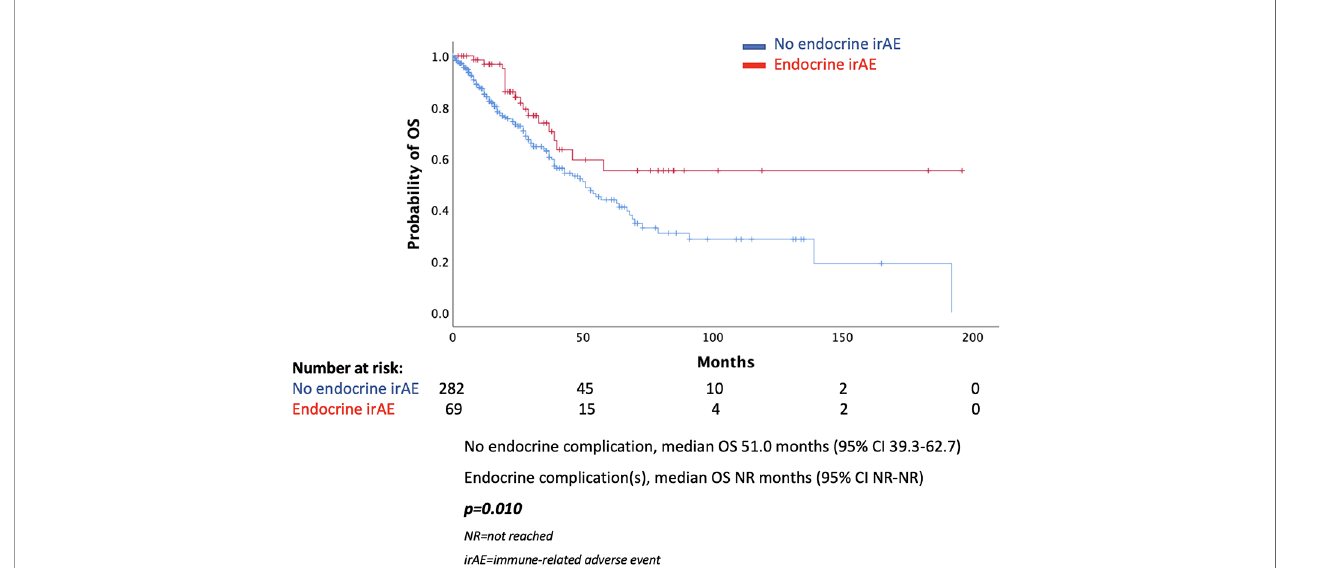
FIGURE 2 | Overall survival according to the presence of endocrine complications.